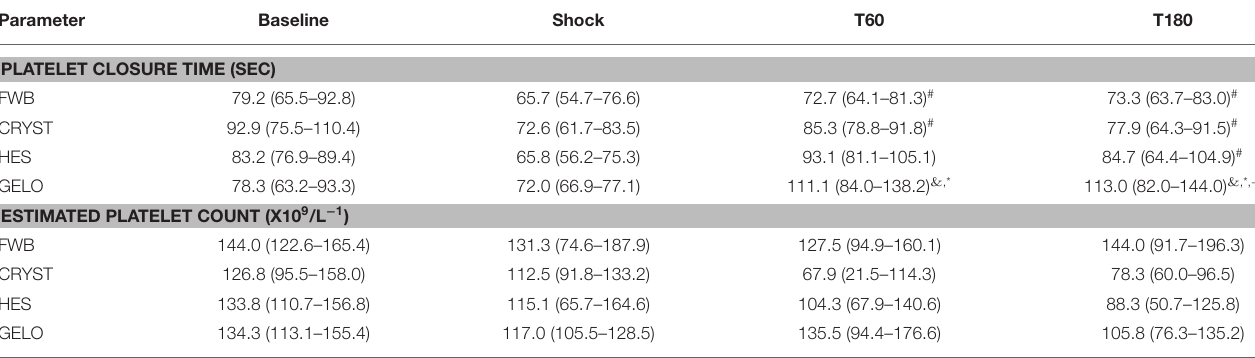
TABLE 1 | Platelet closure time and count (mean, 95% confidence interval) in dogs ( n = 6 per group) with hemorrhagic shock given 20mL kg − 1 of either fresh whole blood (FWB), hydroxyethyl starch 130/0.4 (HES), 4% succinylated gelatin (GELO), or 80mL kg − 1 of balanced isotonic crystalloid